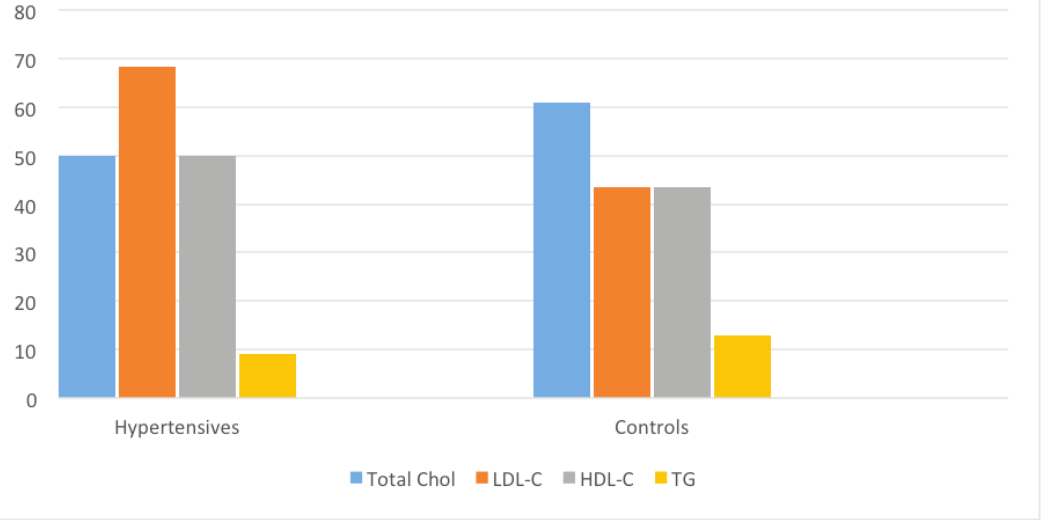
Supplementary Figure 1: Pattern of Dyslipidaemia among Hypertensives and Controls More of the hypertensive patients (60) (68.2%) had elevated LDL-cholesterol >3.4 mmol/L, whereas more of the control participants (14) (60.9%) had elevated total cholesterol >5.2mmol/L.